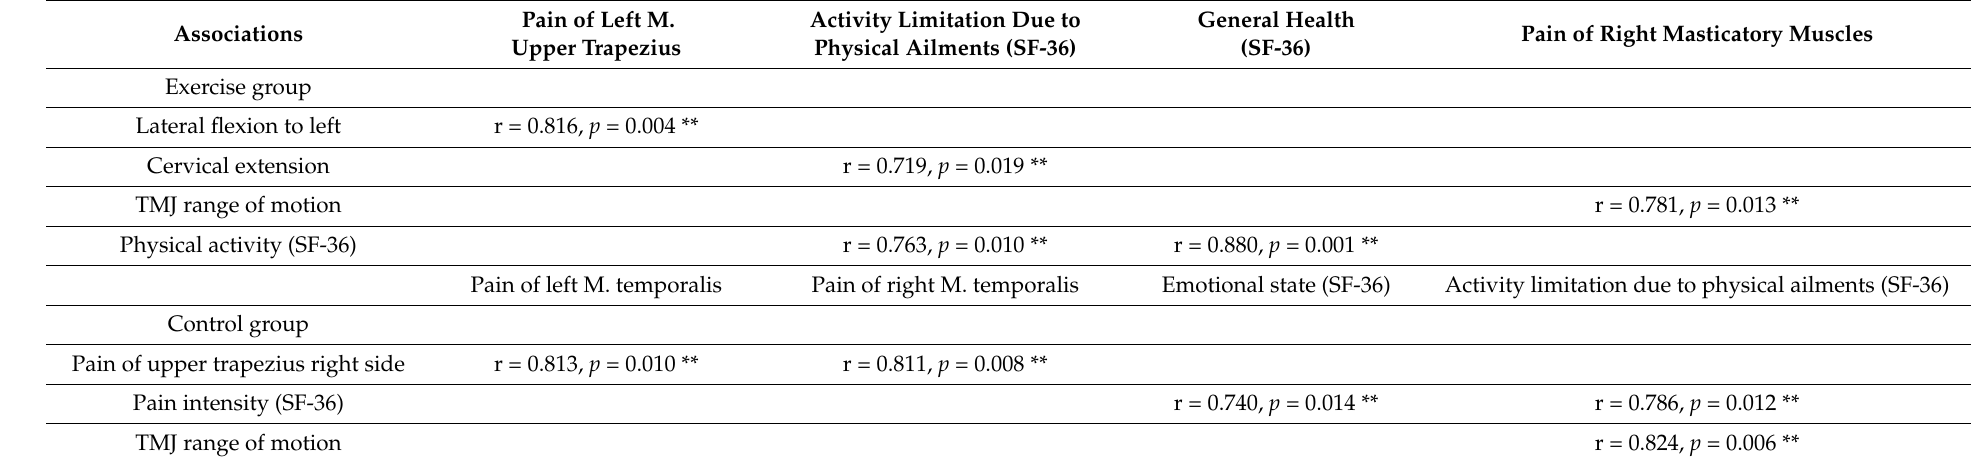
Table 5. Associations between cervical range of motion, pain, temporomandibular joint range of motion and quality of life in individuals with migraine. Pain of Left Associations